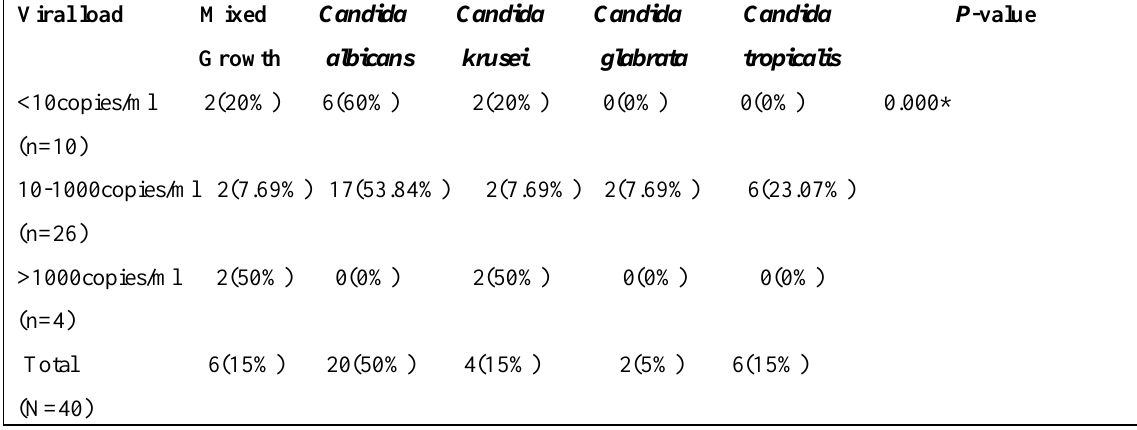
Table 11. Distribution of various Candida isolates in relation to the viral load of the participants. Viral load Mixed Candida Candida Candida Candida P -value Growth albicans krusei